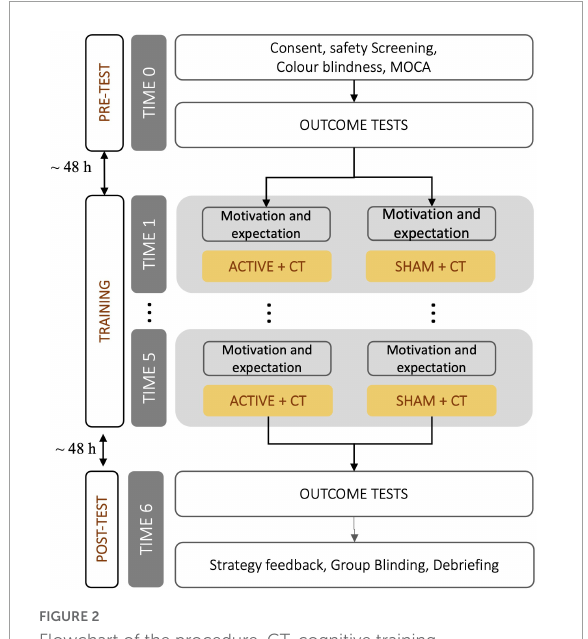
FIGURE2 Flowchart of the procedure. CT, cognitive